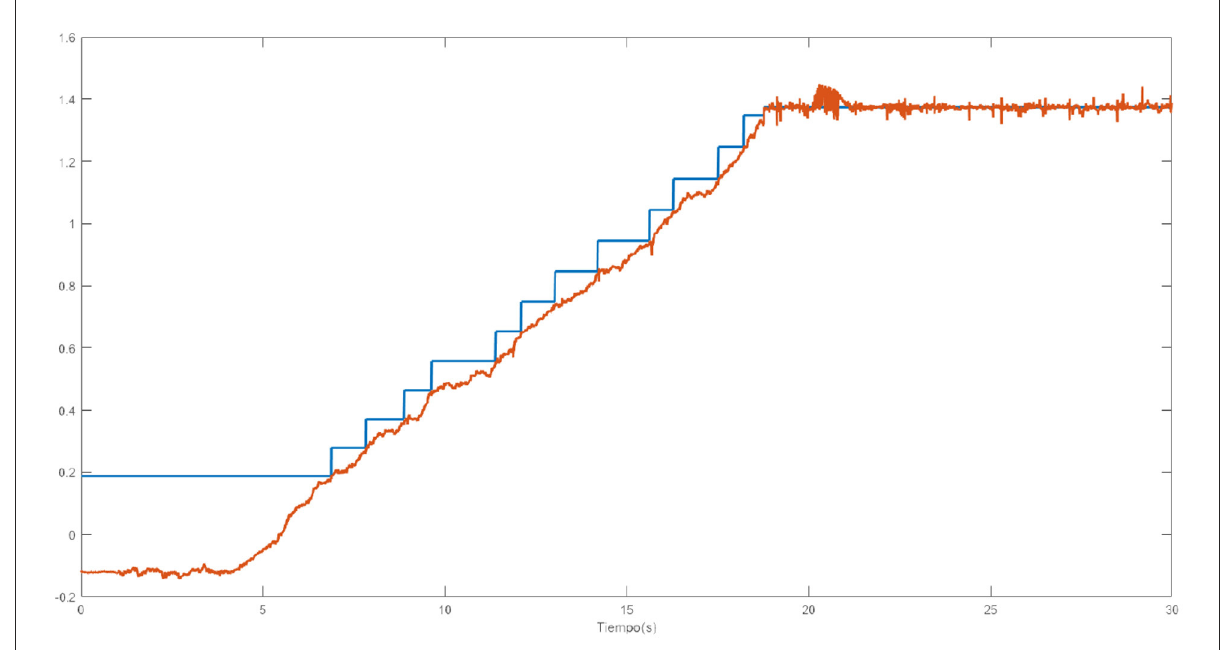
FIGURE8 Output trajectory and target of the neural network.